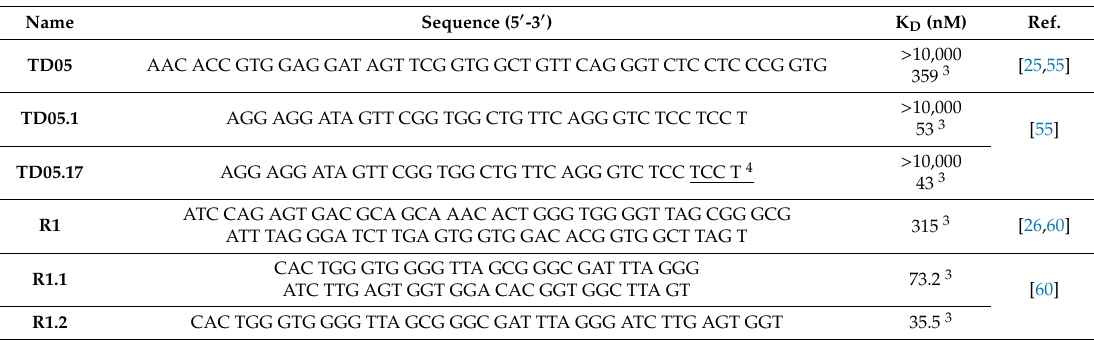
Table 3. Selected aptamers against IgMs and their equilibrium dissociation constants at 37 ◦ C and 4 ◦